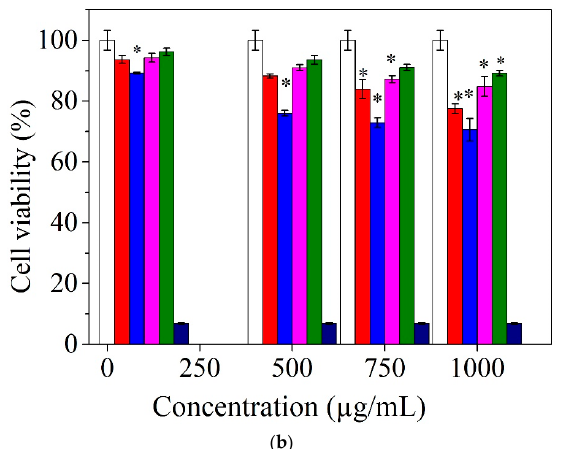
Figure 7. Evaluation of cell viability of the fibroblast cell line (NCTC clone L929) induced by the electrospun collagen and collagen embedded with antimicrobial agents after: ( a ) 24 h and ( b ) 48 h. The results were indicated as mean values ± SD (n = 3). * p < 0.05; (black) control culture , (red) Col—collagen glue nanofibers , (blue) Col/ZnO NPs , (fuchsia) Col/TiO 2 -N-Ag NPs, (green) Col/CS, and (mauve) positive control.